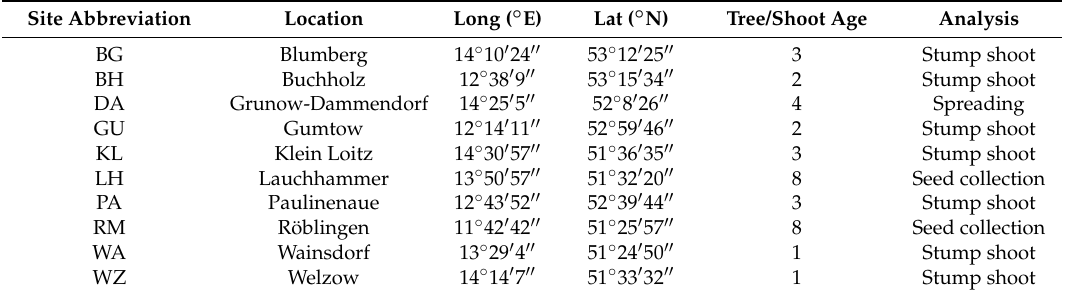
Table 1. Site description including location, longitude (long), latitude (lat), tree/shoot age, and analysis